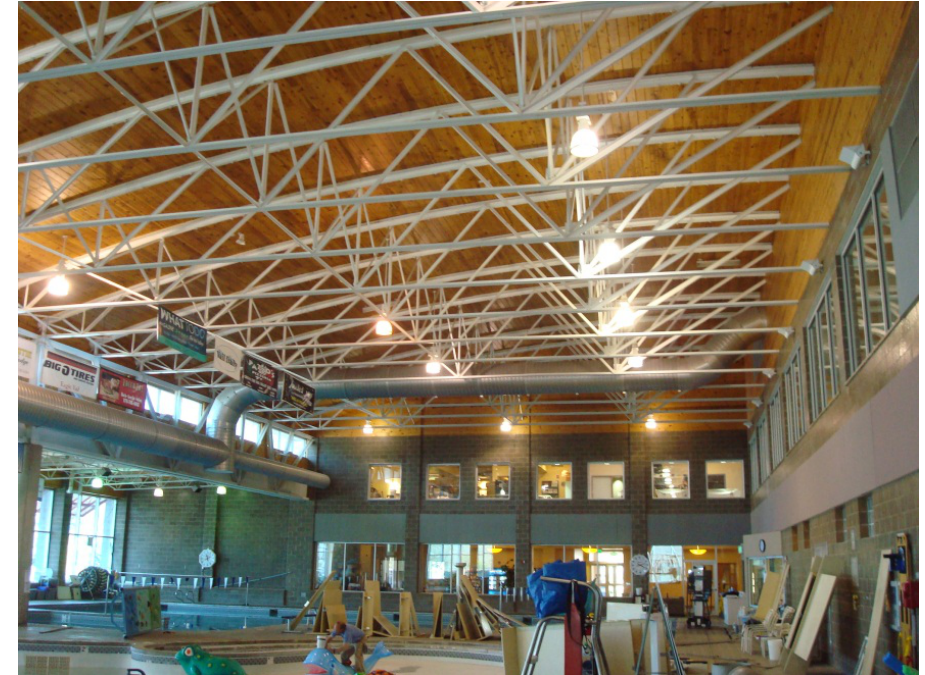
Figure 1. Interior of